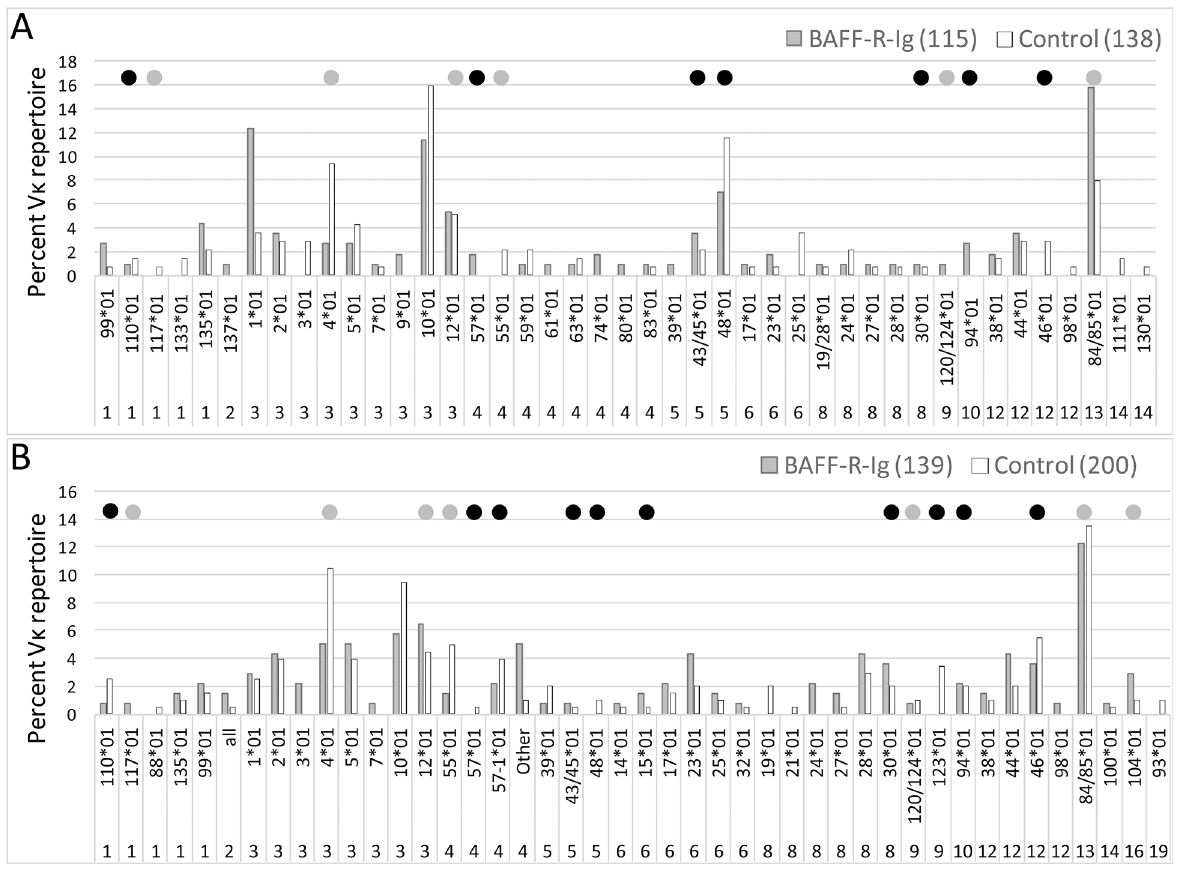
Figure 4. The repertoire of V κ light chains associated with the 3H9 heavy chain in follicular B-cell subsets from NZB/W (A) and NZW/BXSB (B) chimeras. The x axis shows the light-chain gene family and specific genes that were expressed. The y axis shows percent of the total repertoire for each subset. Four to six spleens were analyzed for each subset (see Supplementary Tables S2 and S3 for raw data and statistical analysis). Black dots indicate V κ genes that confer specificity for dsDNA, histones or CL. Grey dots indicate V κ genes without these